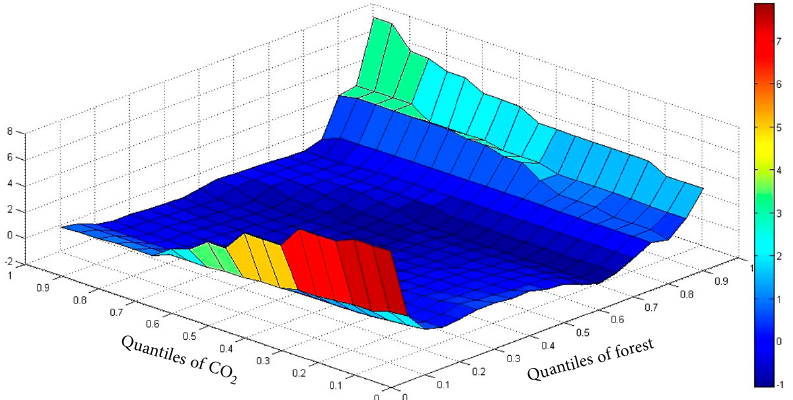
Figure 5. Quantile on quantile regression estimation for Thailand